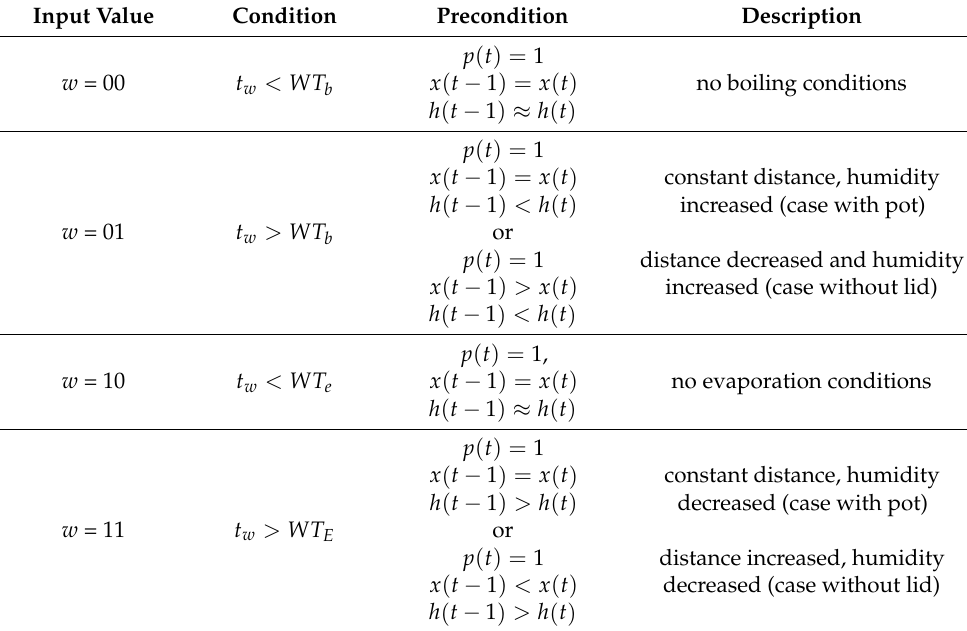
Table 3. Values of the warning parameter w